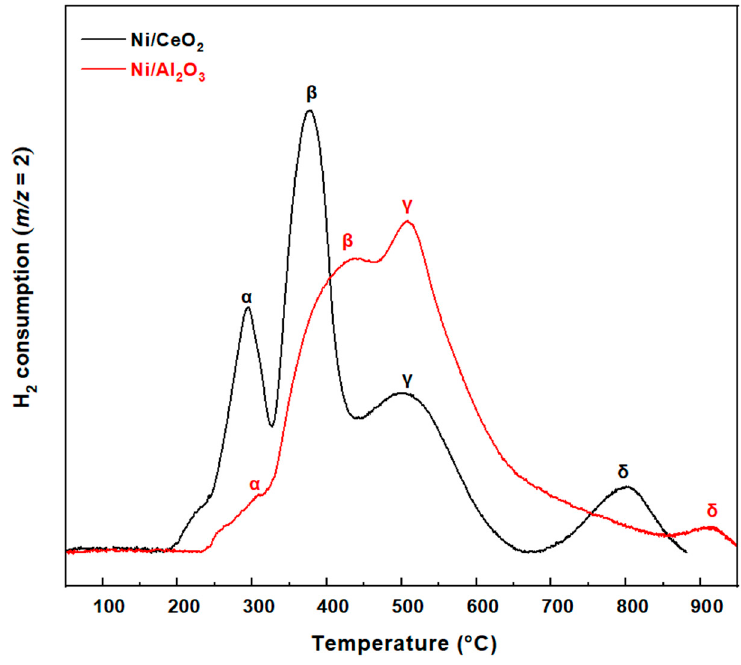
Figure 4. H 2 -TPR profiles of the as-prepared Ni/CeO 2 and Ni/Al 2 O 3 catalysts.